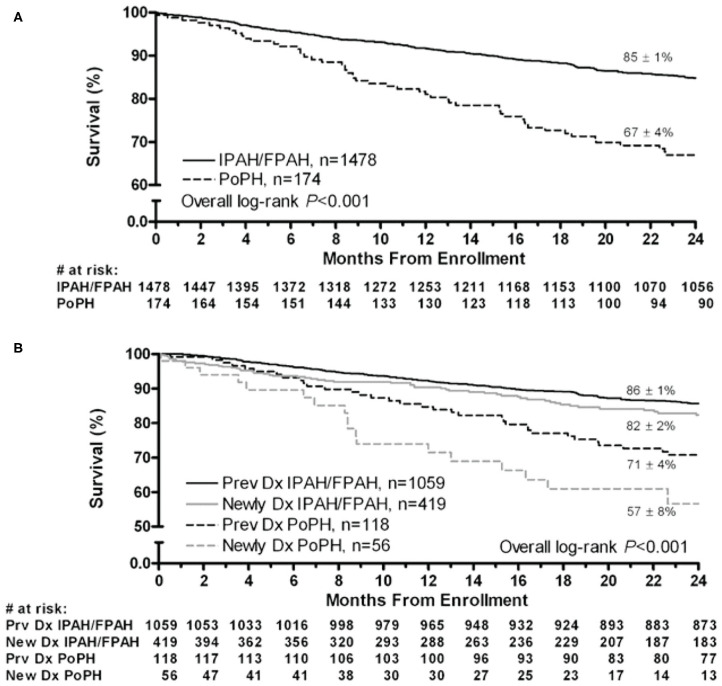
Two-year survival from enrollment. (A) Patients with PoPH and IPAH/FPAH. (B) Stratified by duration of disease from enrollment. Dx, diagnosis; FPAH, familial pulmonary arterial hypertension; IPAH, idiopathic pulmonary arterial hypertension; PoPH, portopulmonary hypertension. Reproduced with permission of Elsevier: Chest 141 (4) 906-915; doi: 10.1378/chest.11-0160 Epub 21 July 2011.